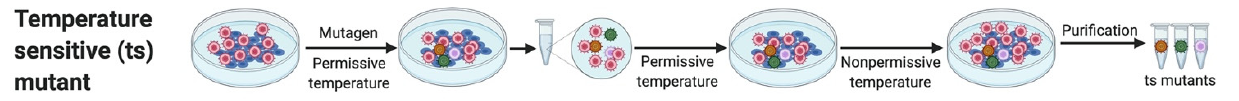
Figure 1. Schematic of generating temperature sensitive (ts) mutants.